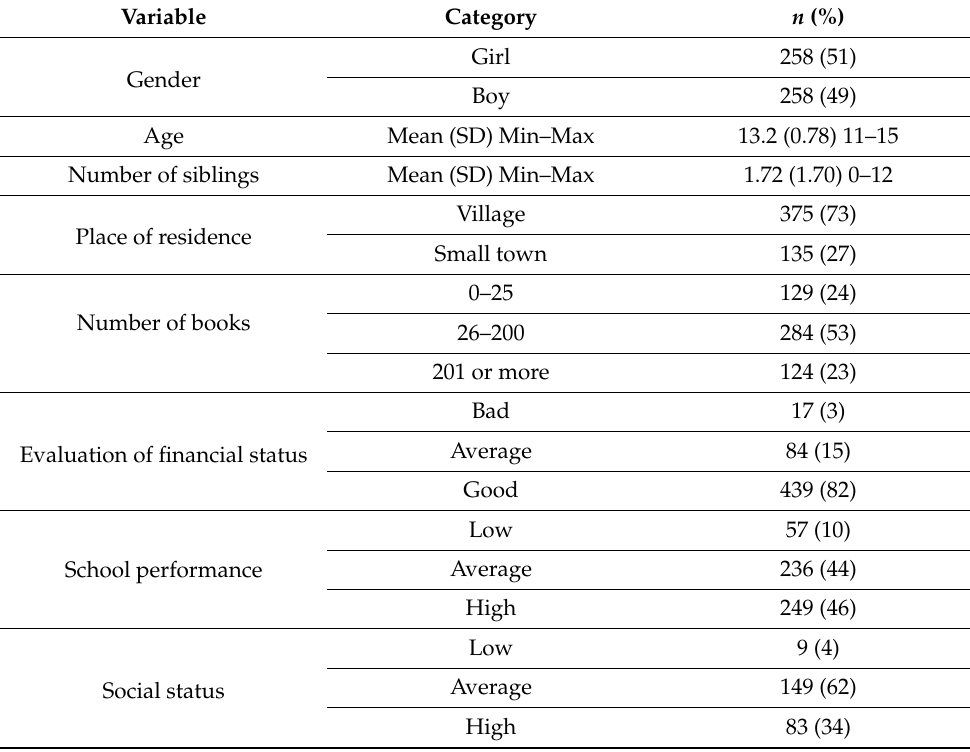
Table 1. Demographic characteristics of the